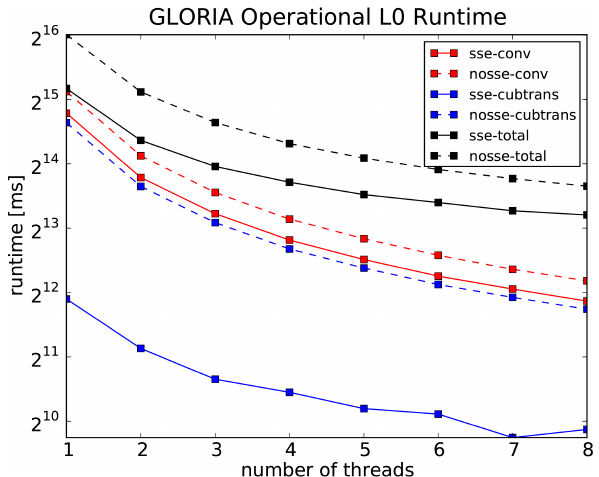
Figure 14. Speedup factor with increasing level of parallelisation for the total processor (black) and the most critical parts (red: con- volution, blue: cuboid transposition). A speedup factor of α means that, at the indicated number of threads, the code in question runs α times as fast as the same code with only a single thread. Both the vectorised (solid lines) and the non-vectorised implementation (dashed lines) are shown for